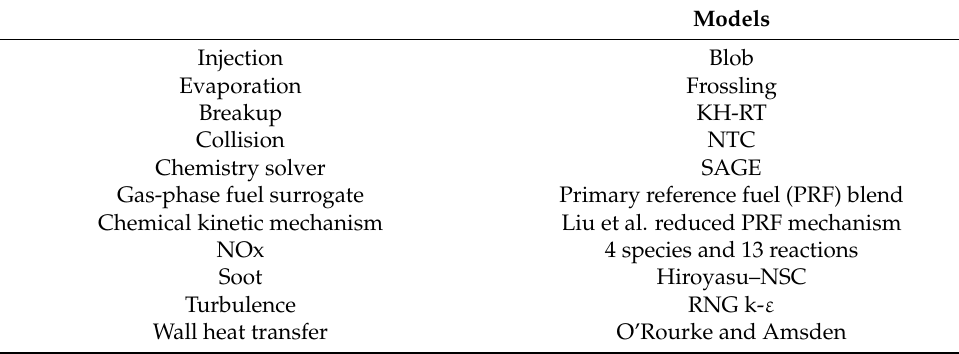
Table 2. Primary Converge sub-models (adapted from